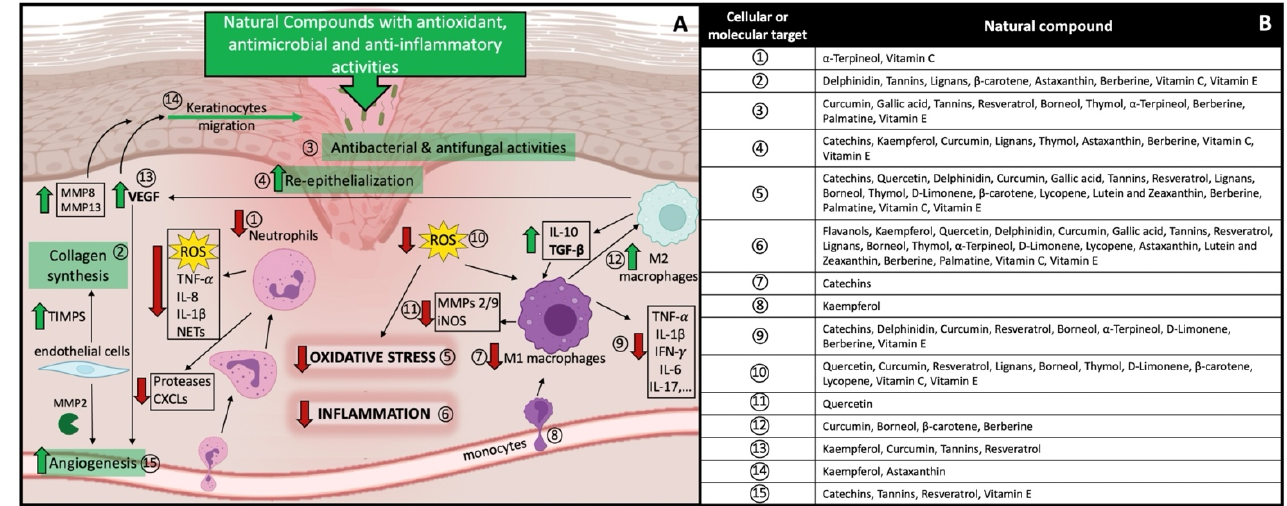
Figure 5. Graphical representation of infected chronic wound treated with natural bioactive compounds. ( A ) Molecular pathways and main targets affected by the natural compounds described in the manuscript are indicated. The arrows indicate the effects on the targets upon treatment. The numbers refer to respective targets and the natural compounds that seem to be best for the treatment as shown in ( B ).